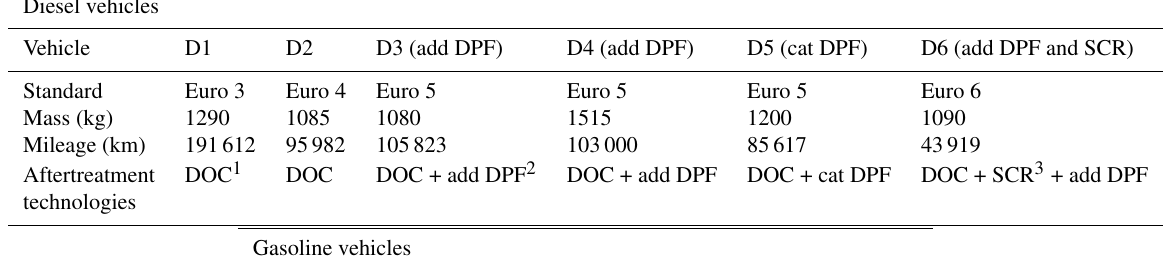
Table 1. Characteristics of the diesel and gasoline vehicles used in this study for the chamber characterization and the particle evolution. Diesel vehicles